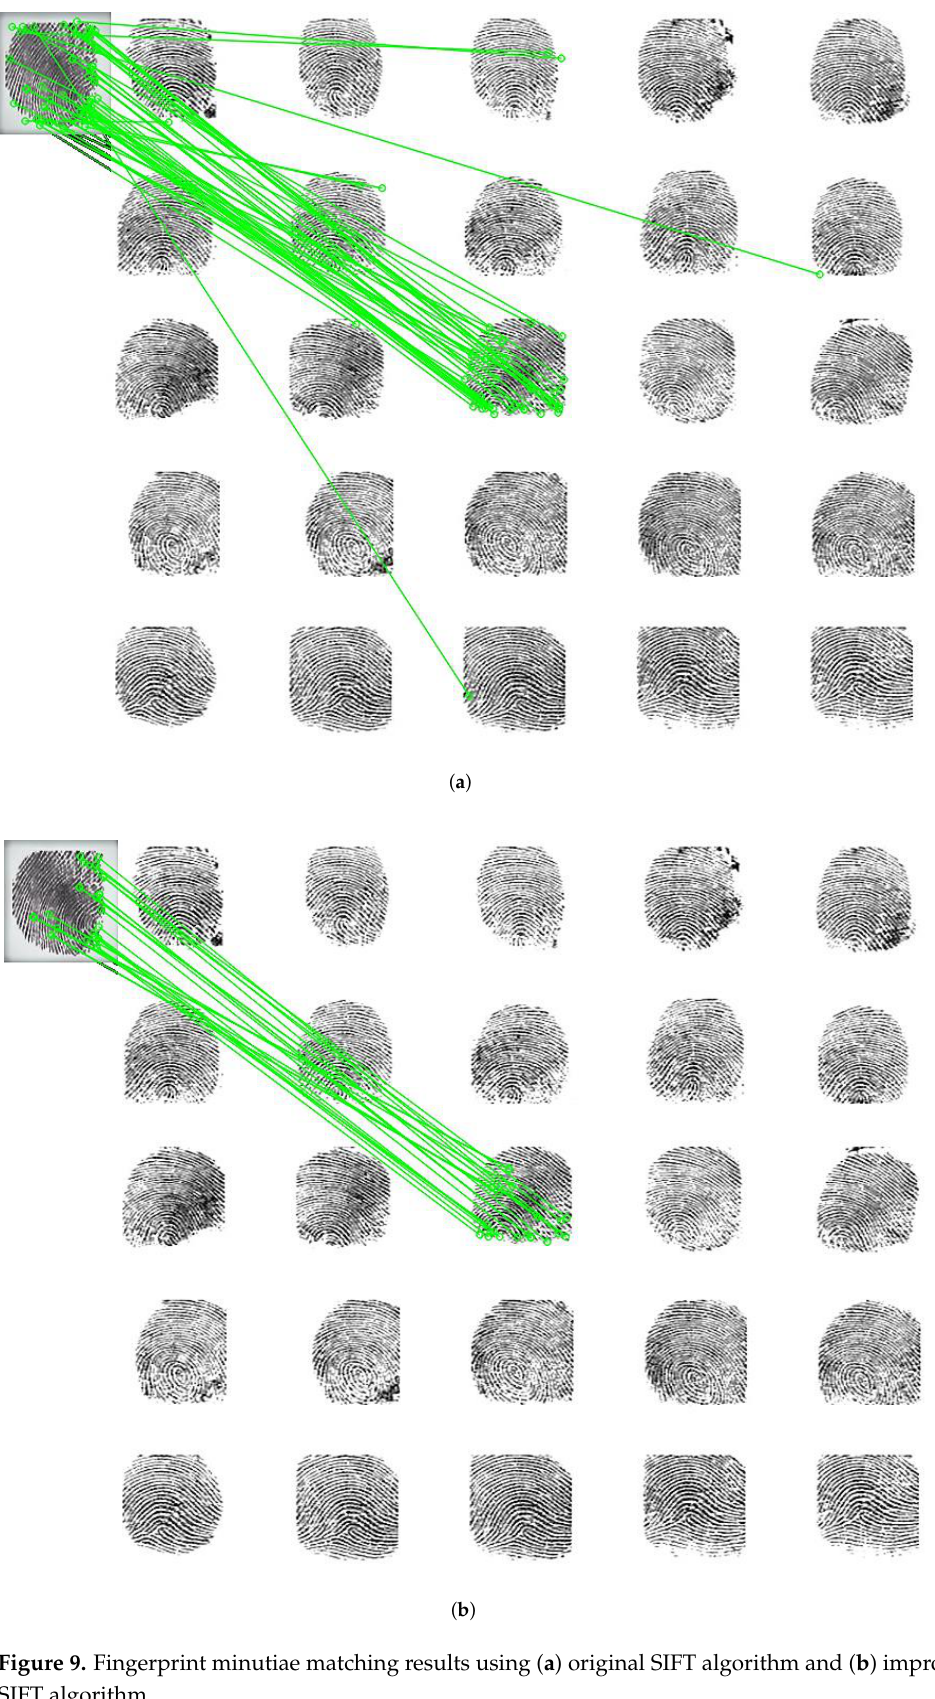
Figure 9. Fingerprint minutiae matching results using ( a ) original SIFT algorithm and ( b ) improved SIFT